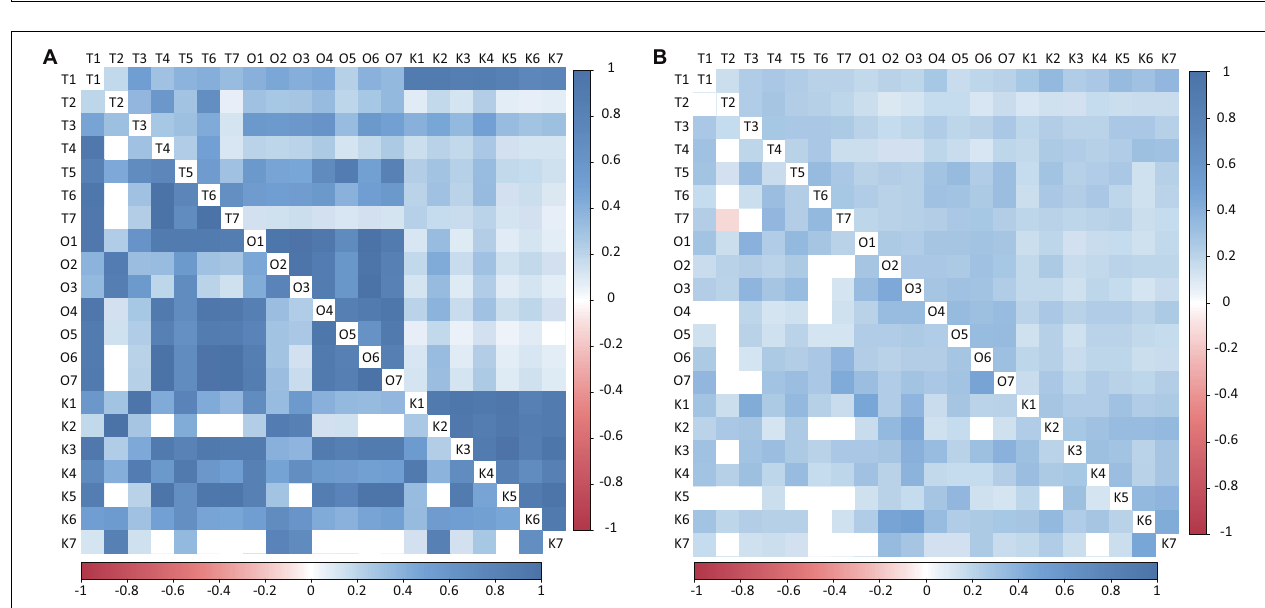
FIGURE 3 | Top 20 bacterial genera in Kochi, Okinawa, and Taiwan.